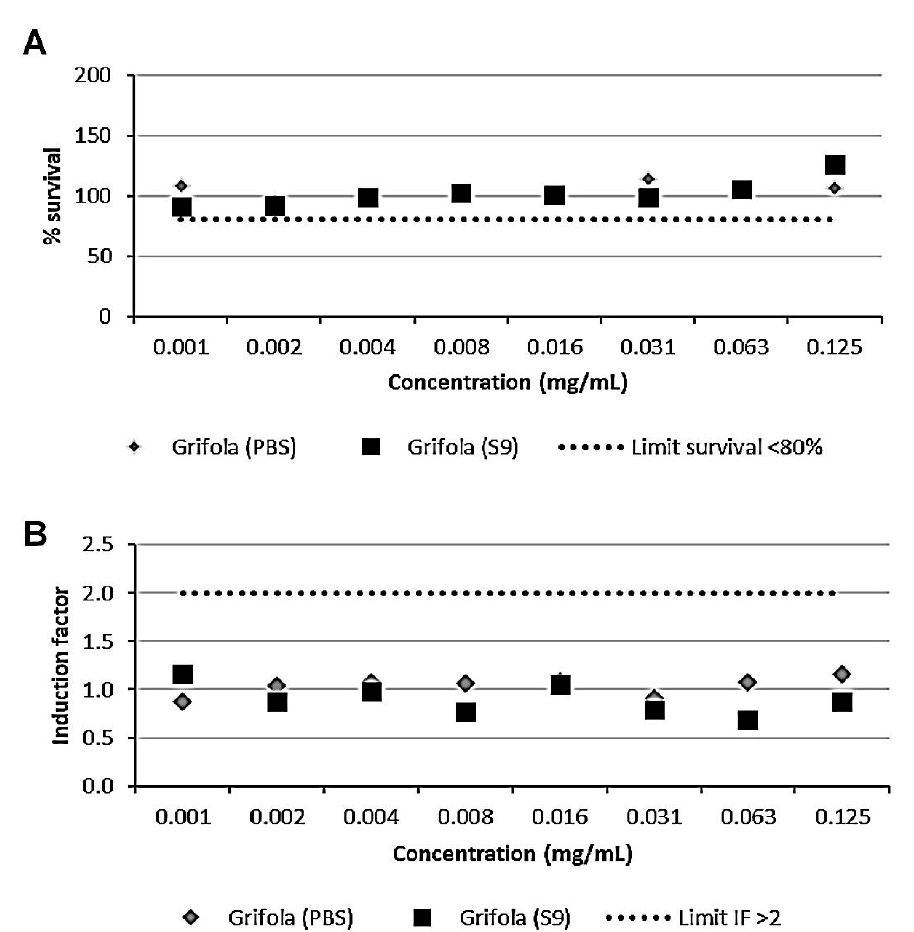
Figure 1. Results from SOS/umu test with (black) or without (grey) S9 activation. ( A ) Bacterial sur- vival is shown as a percentage. Concentrations are considered nontoxic if survival is > 80%. ( B ) Genotoxicity. A compound is considered genotoxic if the induction factor is ≥ 2 at nontoxic concen- trations for the bacteria in any of the conditions tested.